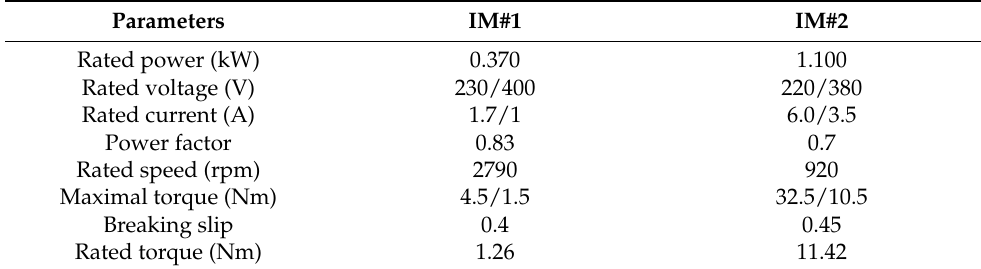
Data of the studied machines are given in Table A3. Table A3.